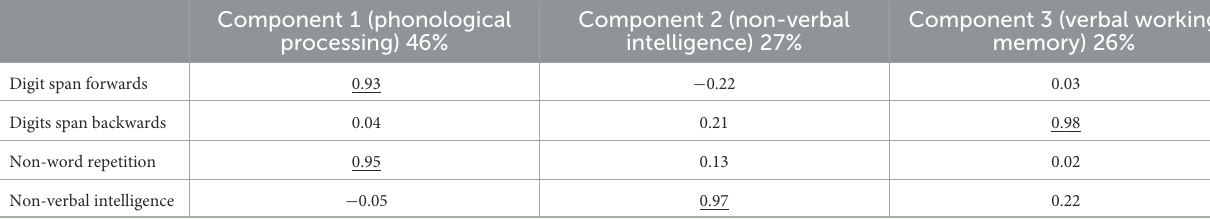
TABLE 5 Standardized loadings of the component scores from the